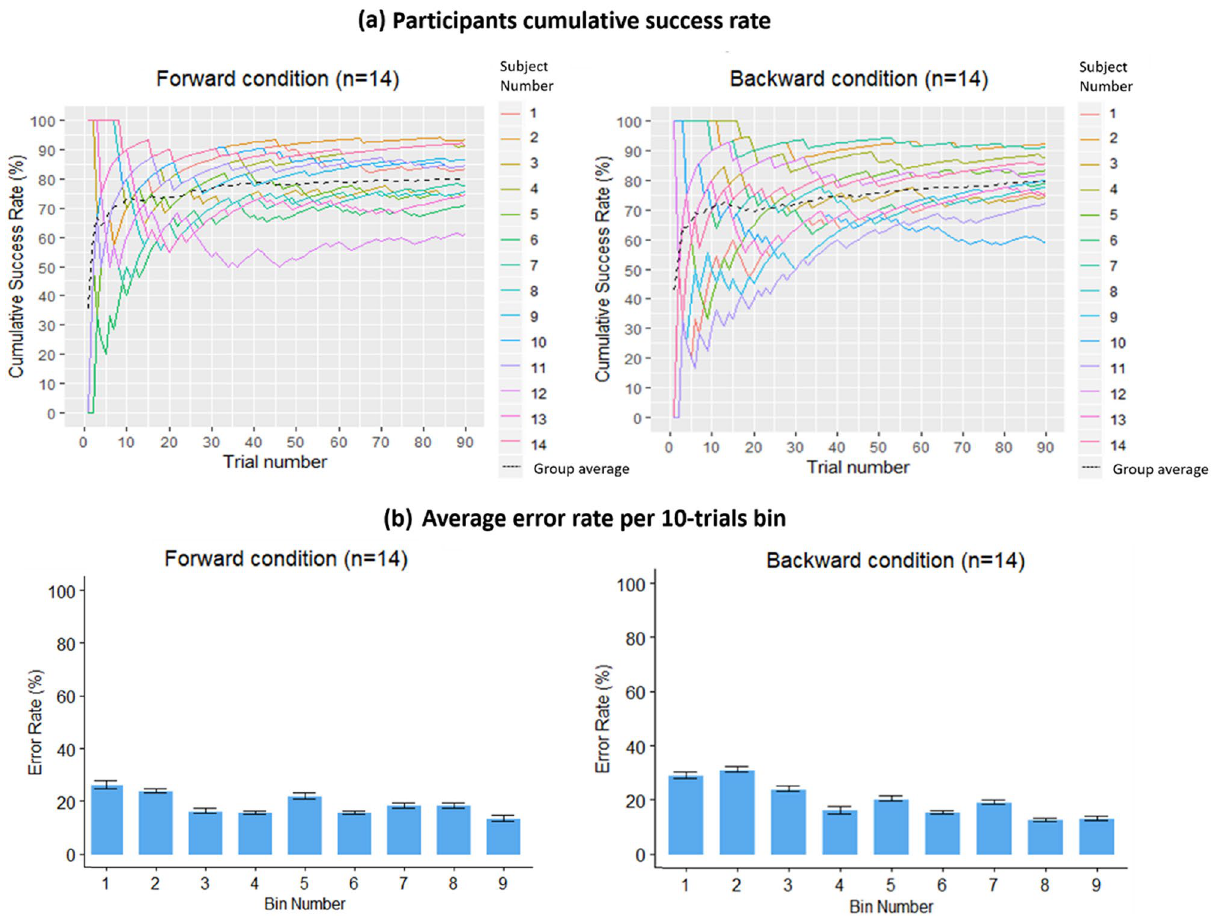
Figure 4. ( a ) Cumulative success rate for each participant as a function of trial number. Upper left: Blindfolded sighted participants in the forward condition (n = 14). Upper right: Blindfolded sighted participants in the backward condition (n = 14). In both panels, cumulative success rate for each subject is represented by a different colored line, while the group average is represented by the dashed black line. Both groups show a steep increase in accuracy within the first ten trials, after which all participants reach a plateau, maintaining a relatively stable performances for the rest of the experiment. ( b ) Average error rate as a function of the bin number across the experiment. Bottom left: Blindfolded sighted participants in the forward condition (n = 14). Bottom right: Blindfolded sighted participants in the backward condition (n = 14). Each bin represents the average error rate for every 10 trials, and so there are 9 bins representing the course of the 90 trials presented in the experiment. Error bars depict standard deviations from the mean. A tendency for diminishing mistakes during the experiment can be observed, especially for the backward condition. This Figure was created using R Core Team (2018). R: A language and environment for statistical computing. R Foundation for Statistical Computing, Vienna, Austria. R version 3.5.2 (2018-12-20). https:// www.R- proje ct.